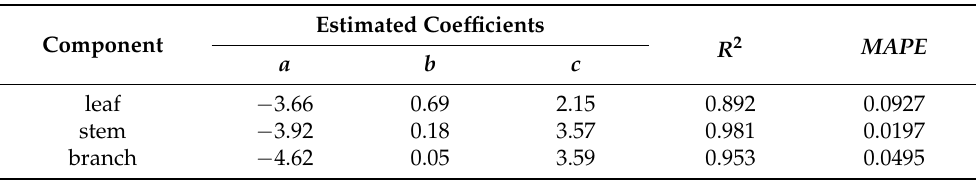
Table 3. Parameter estimates ( a , b and c ) and evaluation statistics ( R 2 and MAPE ) of Equation (5) for different components using SUR approach.